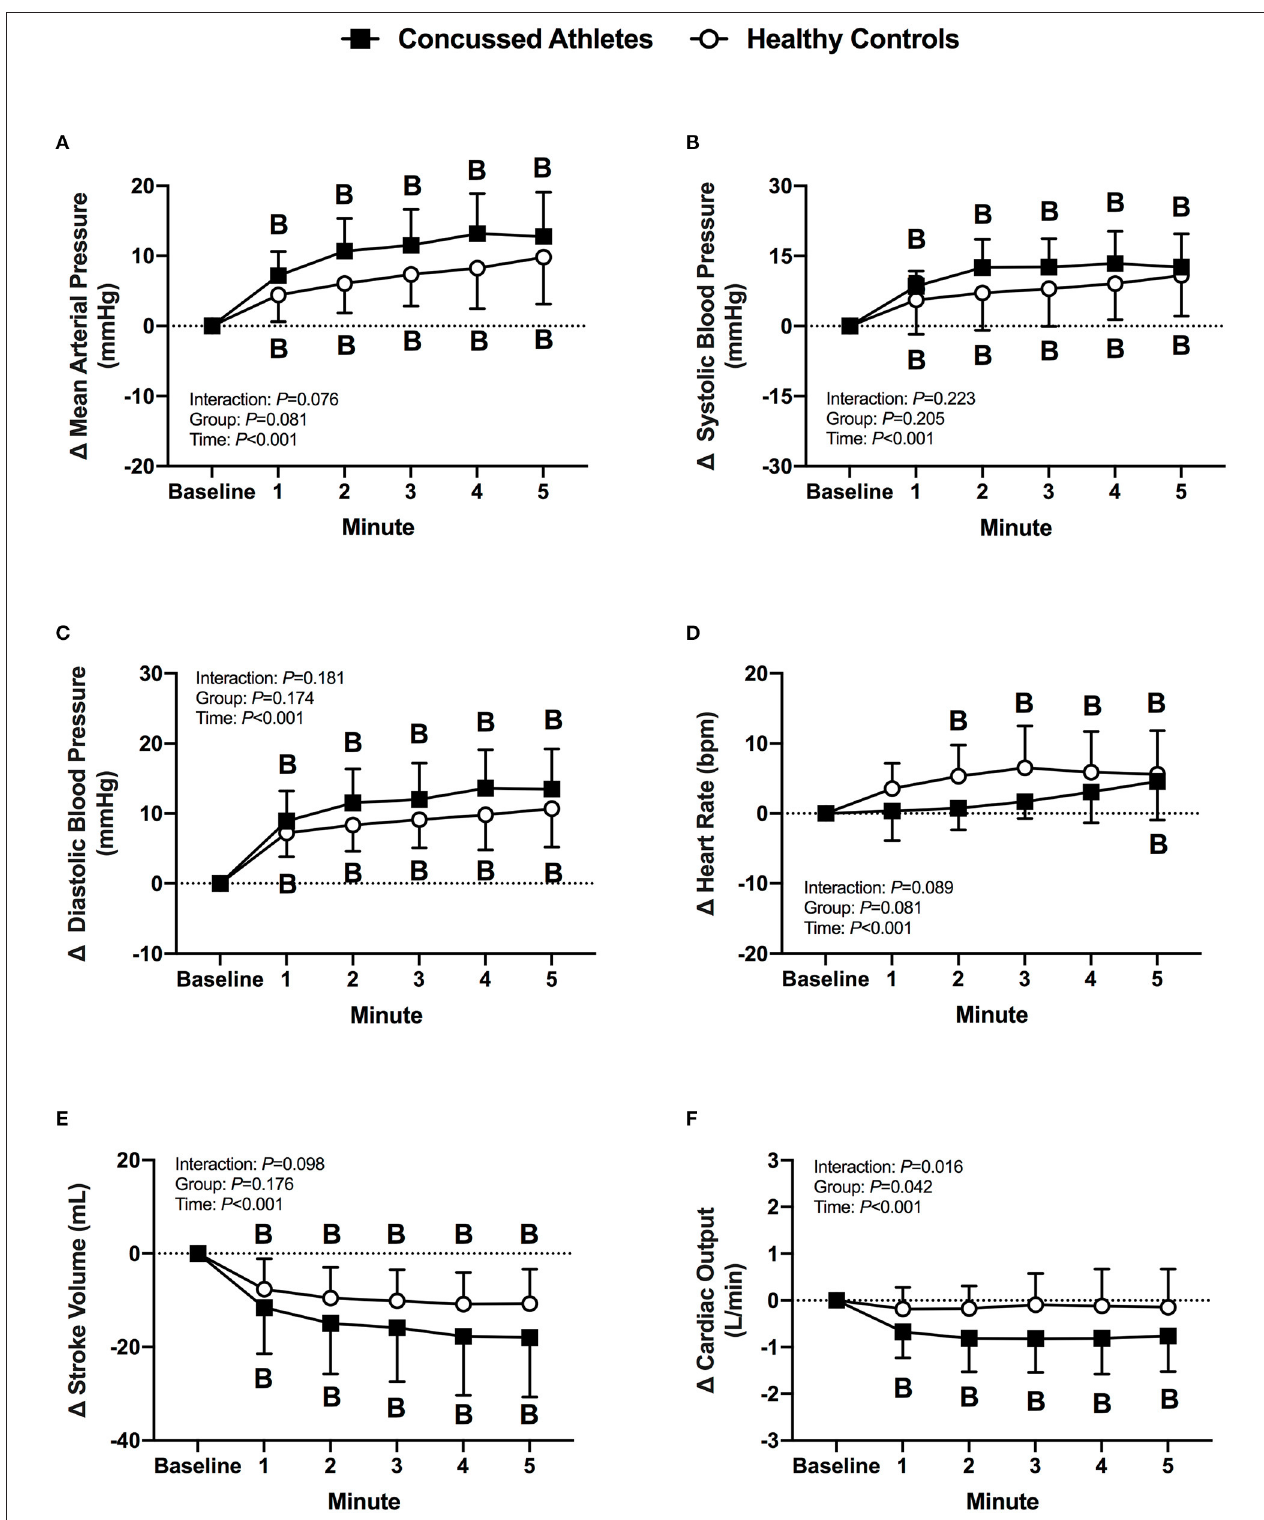
FIGURE 6 | The change from baseline in mean arterial pressure (A) , systolic blood pressure (B) , diastolic blood pressure (C) , heart rate (D) , stroke volume (E) , and cardiac output (F) at each minute of LBPP for concussed athletes ( n = 10) and healthy controls ( n = 10). B, different from Baseline ( P ≤ 0.05).